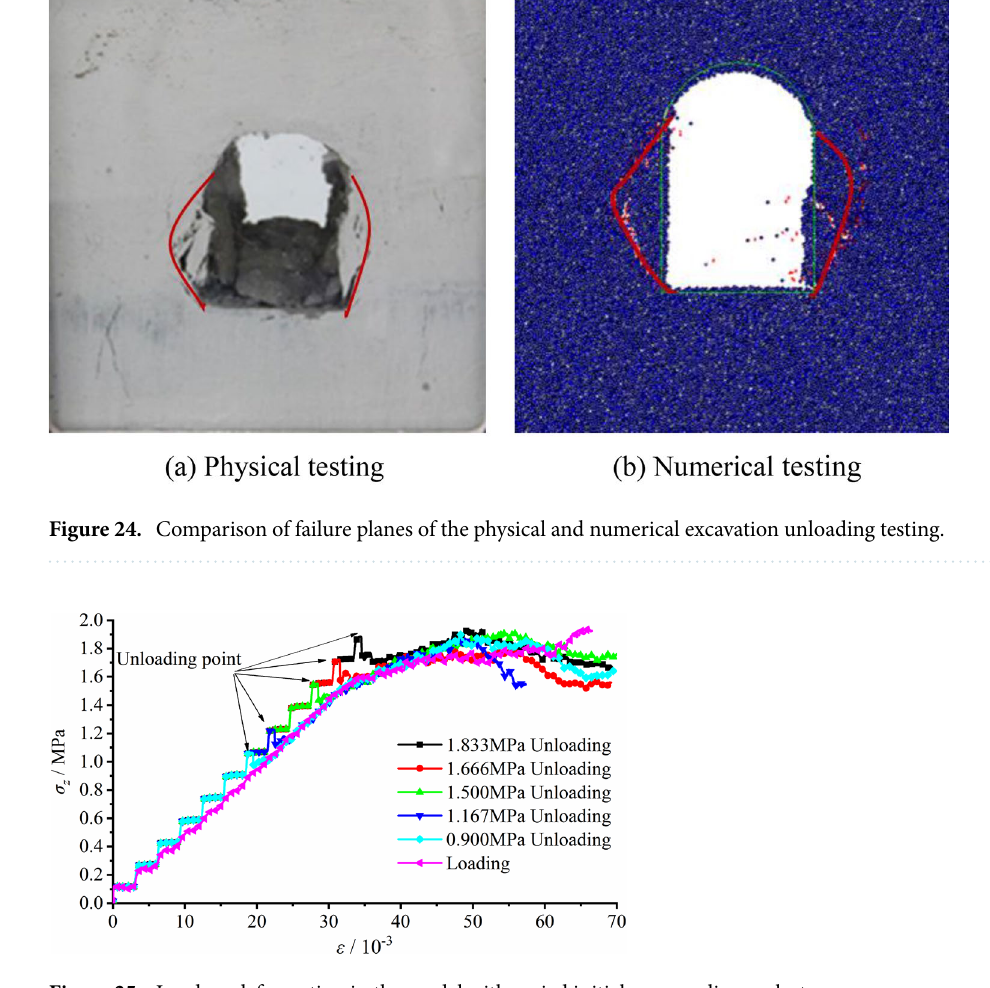
Figure 25. Load vs. deformation in the model with varied initial surrounding rock